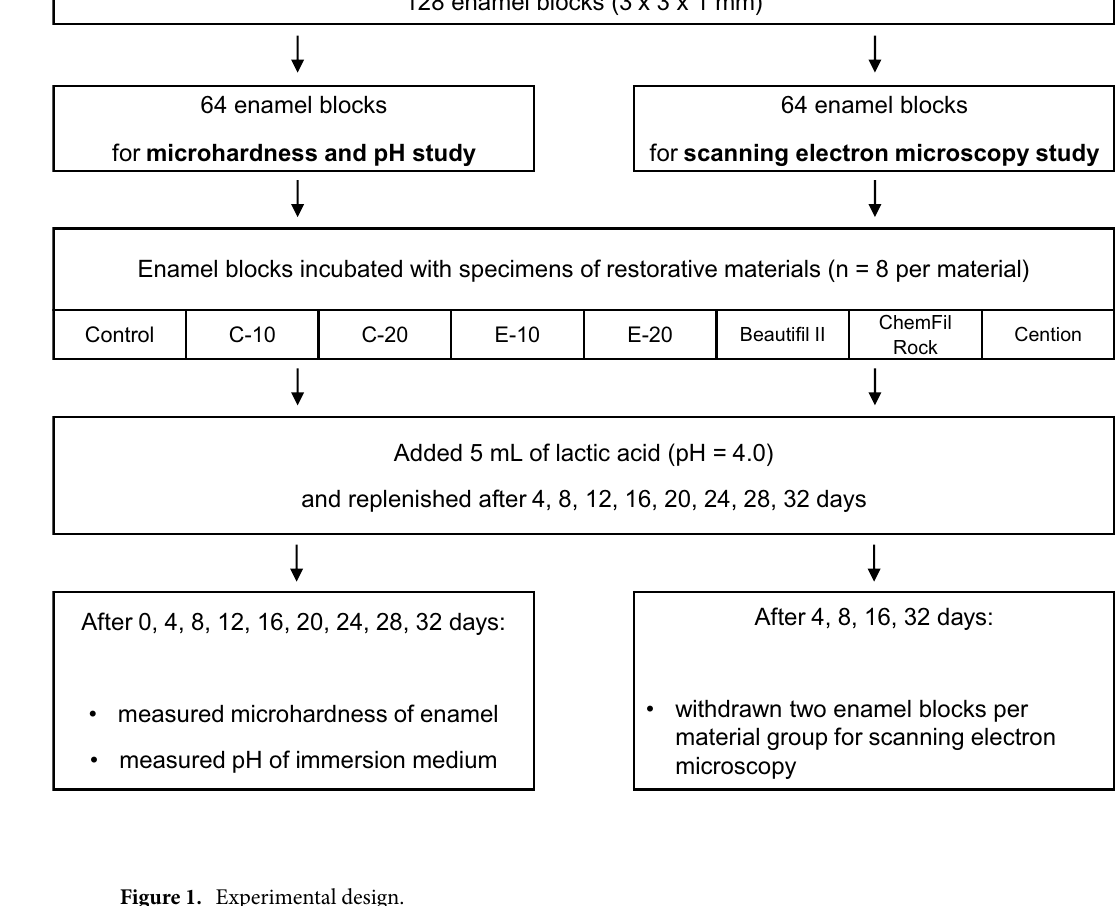
Figure 1. Experimental